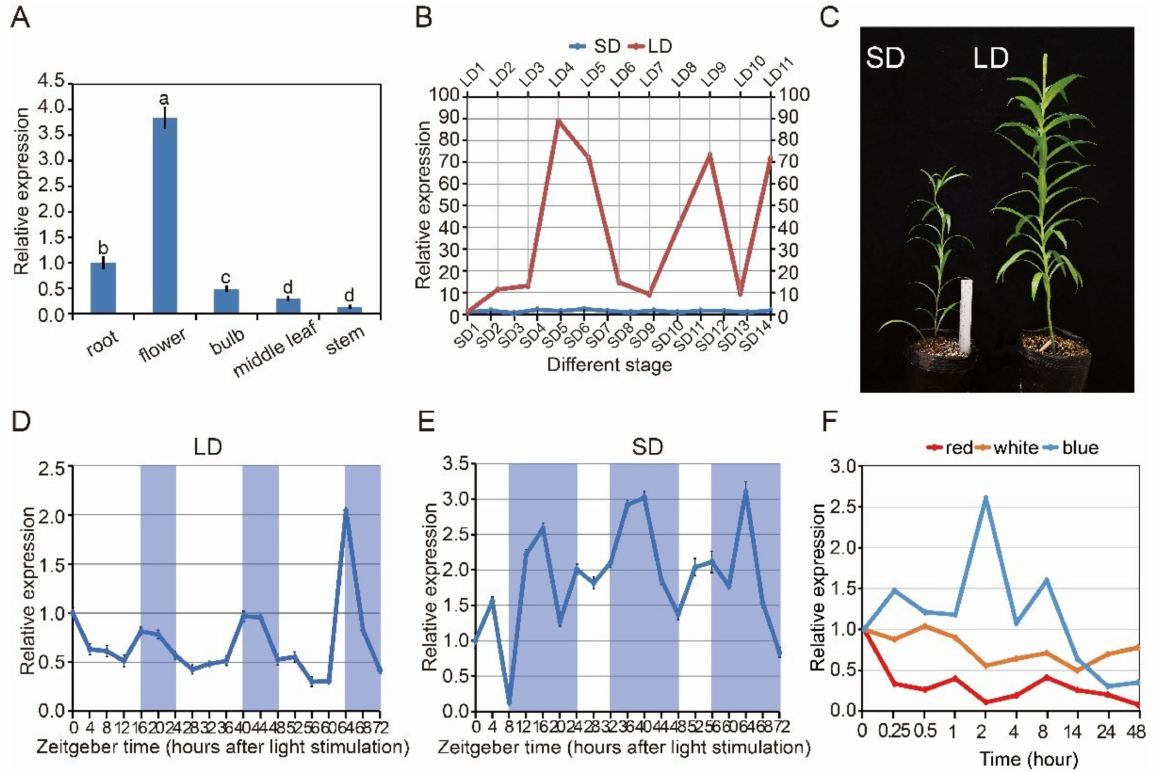
Figure 3. Analysis of LfCRY2 expression using real-time quantitative RT-qPCR. ( A ) LfCRY2 transcript levels in different tissues at the flowering stage under LDs (17.0 µ mol m − 2 s − 1 white light, light/dark cycle of 16/8 h). ( B ) The stage-specific expression patterns of LfCRY2 in the leaves under different photoperiods. Developmental stages corresponding to each time point are as follows: LD1, 2–3 rosette leaves; LD2, 4–5 rosette leaves; LD3, 6–7 rosette leaves; LD4, 8–9 rosette leaves; LD5, 1–2 internodes (just bolting); LD6, 4–5 internodes; LD7, 7–8 internodes; LD8, 13–14 internodes; LD9, 15–16 internodes; LD10, 22–23 internodes; LD11, flowering; SD1, 2–3 rosette leaves; SD2, 4–5 rosette leaves; SD3, 6–7 rosette leaves; SD4, 8–9 rosette leaves; SD5, 10–11 rosette leaves; SD6, 12–13 rosette leaves; SD7, 1–2 internodes (just bolting); SD8, 3–4 internodes; SD9, 5–6 internodes; SD10, 7–8internodes; SD11, 9–10 internodes; SD12, 12–13 internodes; SD13, 16–17 internodes; SD14, 20–21 internodes. ( C ) Growth and development of L. × formolongi in different photoperiod. ( D , E ) The diurnal rhythm expression pattern of LfCRY2 under LDs and SDs. The shaded bars in each chart represent dark periods. ( F ) LfCRY2 transcript levels under different light quality during different irradiation time. Data points represent an average of three biological replicates with three technical replicates. Error bars represent the SD of three biological